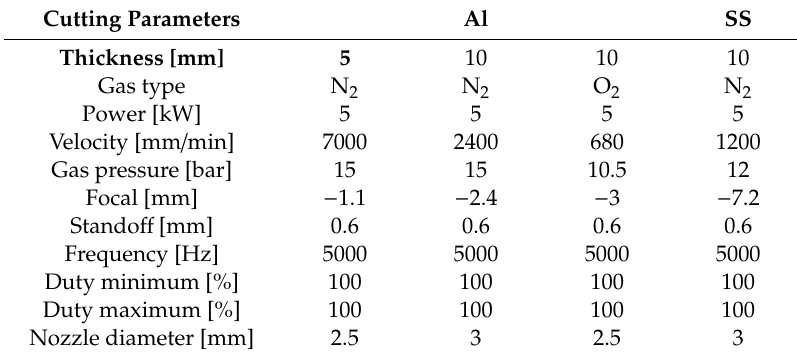
Table 1. Cutting parameters for 10 mm-thick stainless steel (SS) plate, and 5 and 10 mm-thick aluminum (Al) plates.